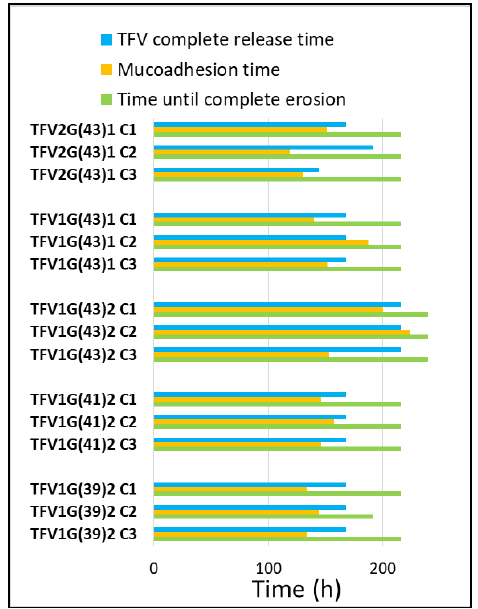
Figure 12. Summary of the data obtained from the drug release, mucoadhesion and swelling test. TFV complete release time (blue), mucoadhesion time (orange) and time until complete erosion (green) are shown for each batch.